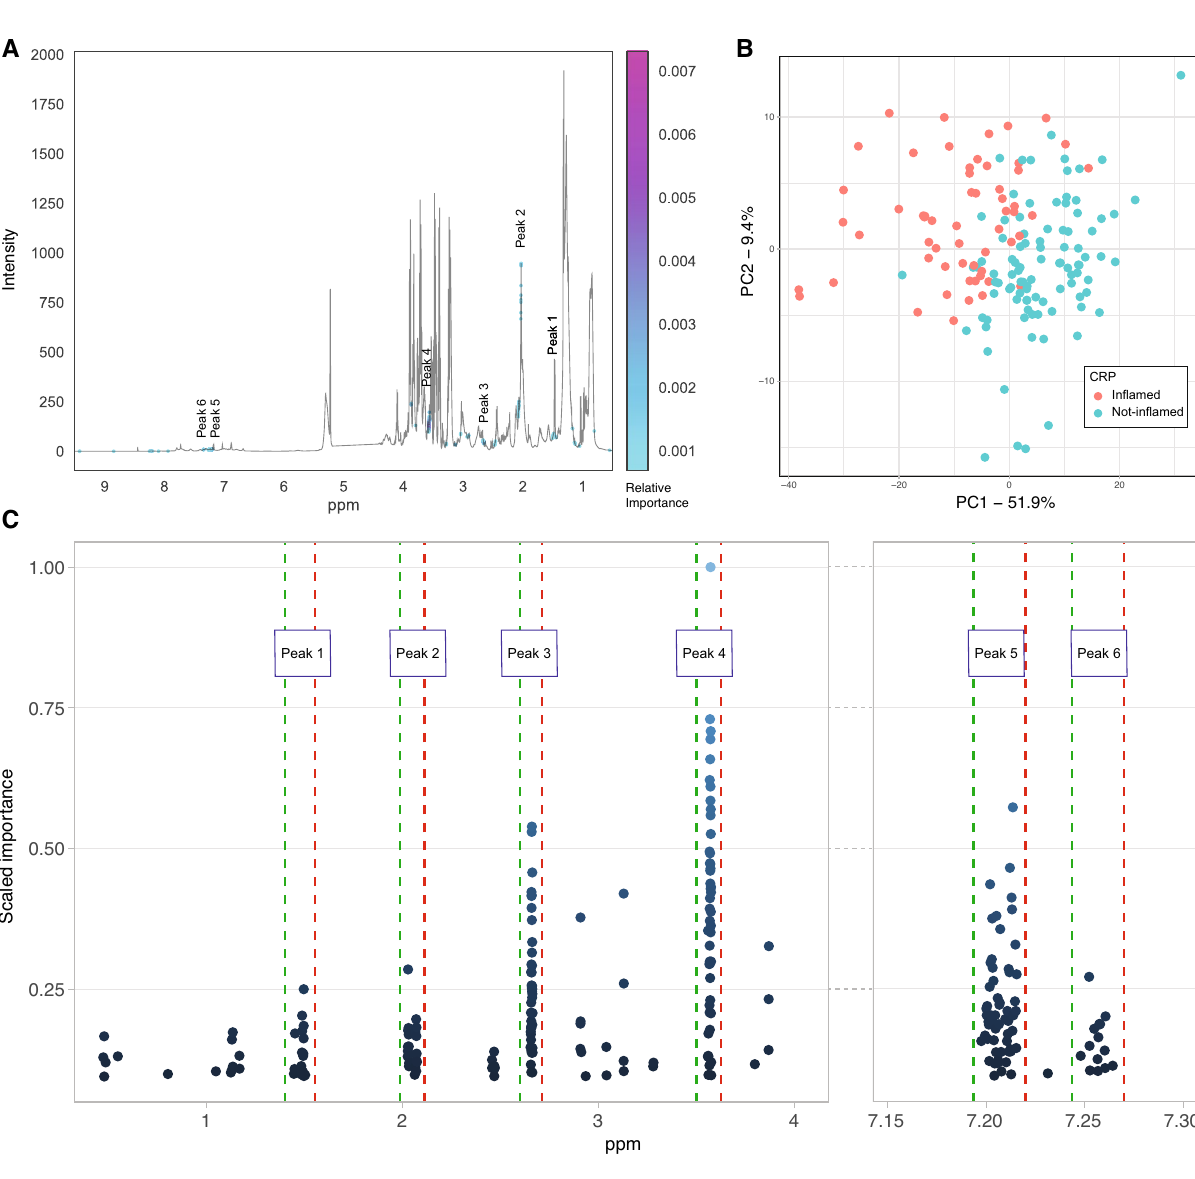
Figure 3. Machine learning classification of patients using NMR data. ( A ) Most informative regions selected by RF model to discriminate patient inflammation status. ( B ) PCA of patient’s spectra using 258 most informative NMR datapoints. ( C ) Distribution of the selected most informative datapoints by their shift δ (ppm) and importance. Green and red dashed lines indicate the start and end of a